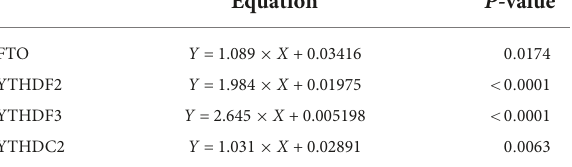
TABLE 4 The linear equations between FTO, YTHDF2, YTHDF3, and